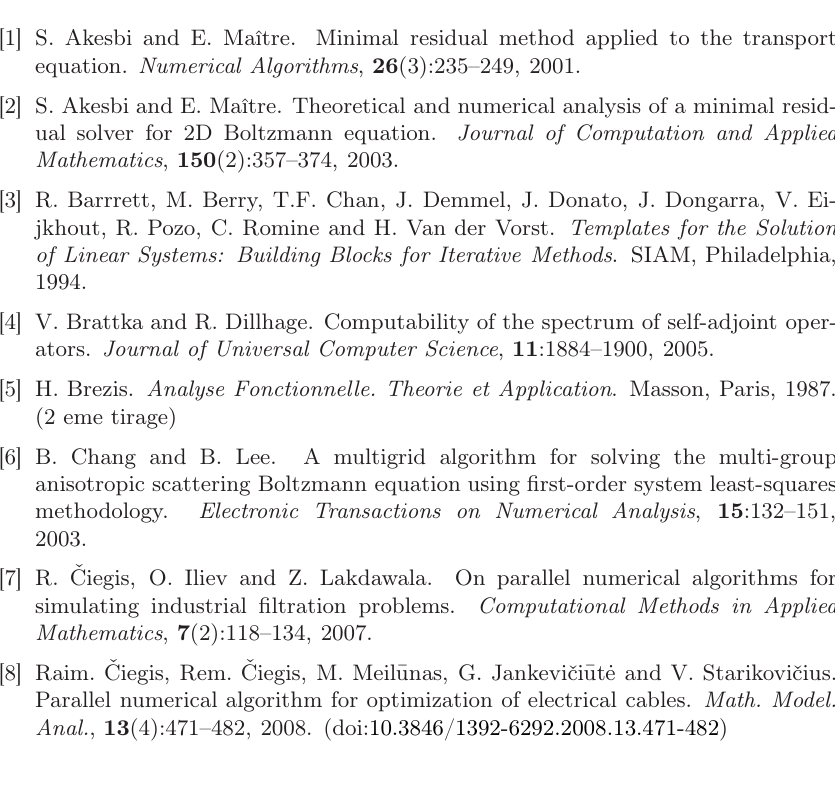
Figure 8. Convergence of the SAS, fgm- res and MG ( c = 0 . 5 ) methods at fixed σ = 100 .